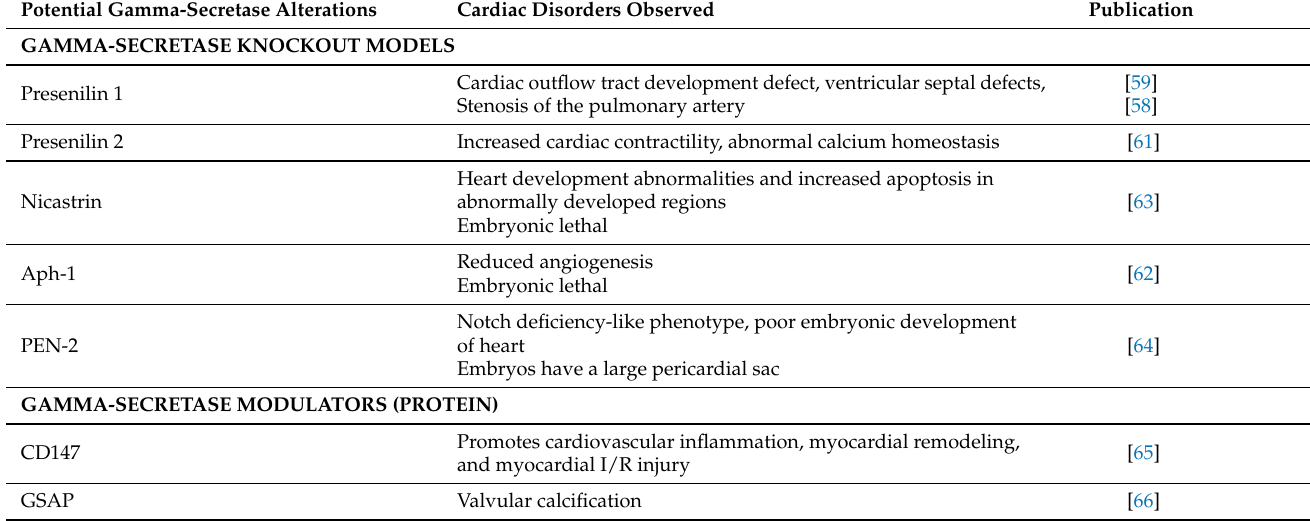
Table 2. Gamma-secretase alterations and corresponding cardiac phenotypes. The table summarizes gamma-secretase knockout models, some gamma-secretase modulators (GSMs), and inhibitors (GSIs) that are reported in the literature. Information on how the GSMs and GSIs impact cardiac diseases warrants further